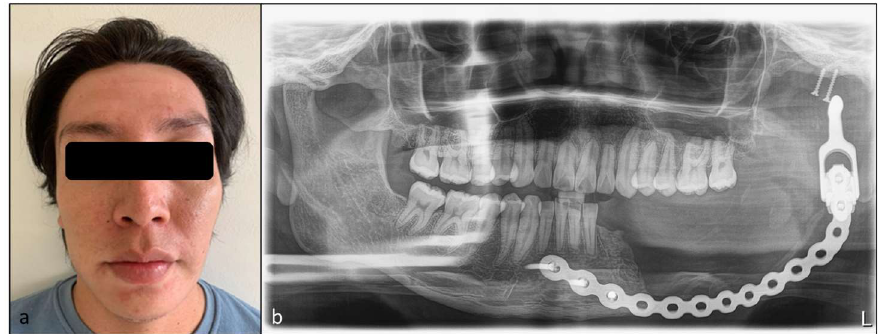
Figure 4. Clinical and imaging status at 15 months of following. ( a ) Extraoral photography of pa- tient, showing symmetric facial appearance without the presence of tumoral remanent. ( b ) Pano- ramic radiography confirming the absence of tumoral remanent and the correct stability of recon- struction bar and personalized PMMA glenoid